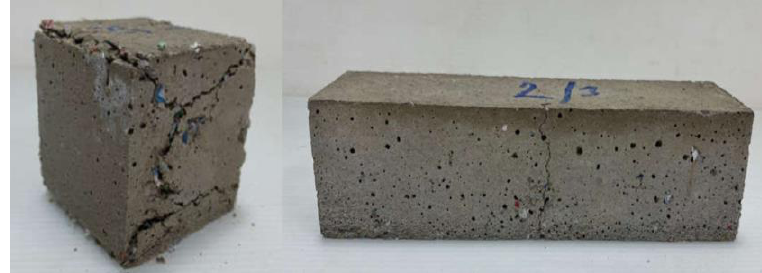
Figure 9. Splitting tensile strength of geopolymer mortar containing BLWA.